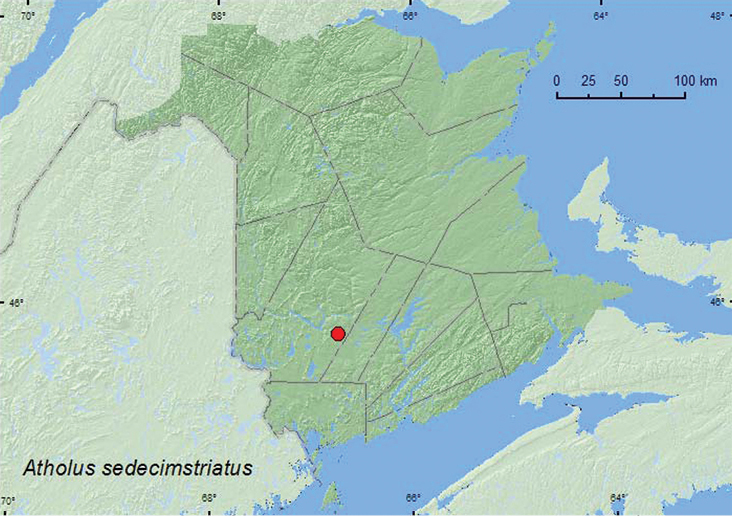
Collection localities in New Brunswick, Canada of Atholus sedecimstriatus.